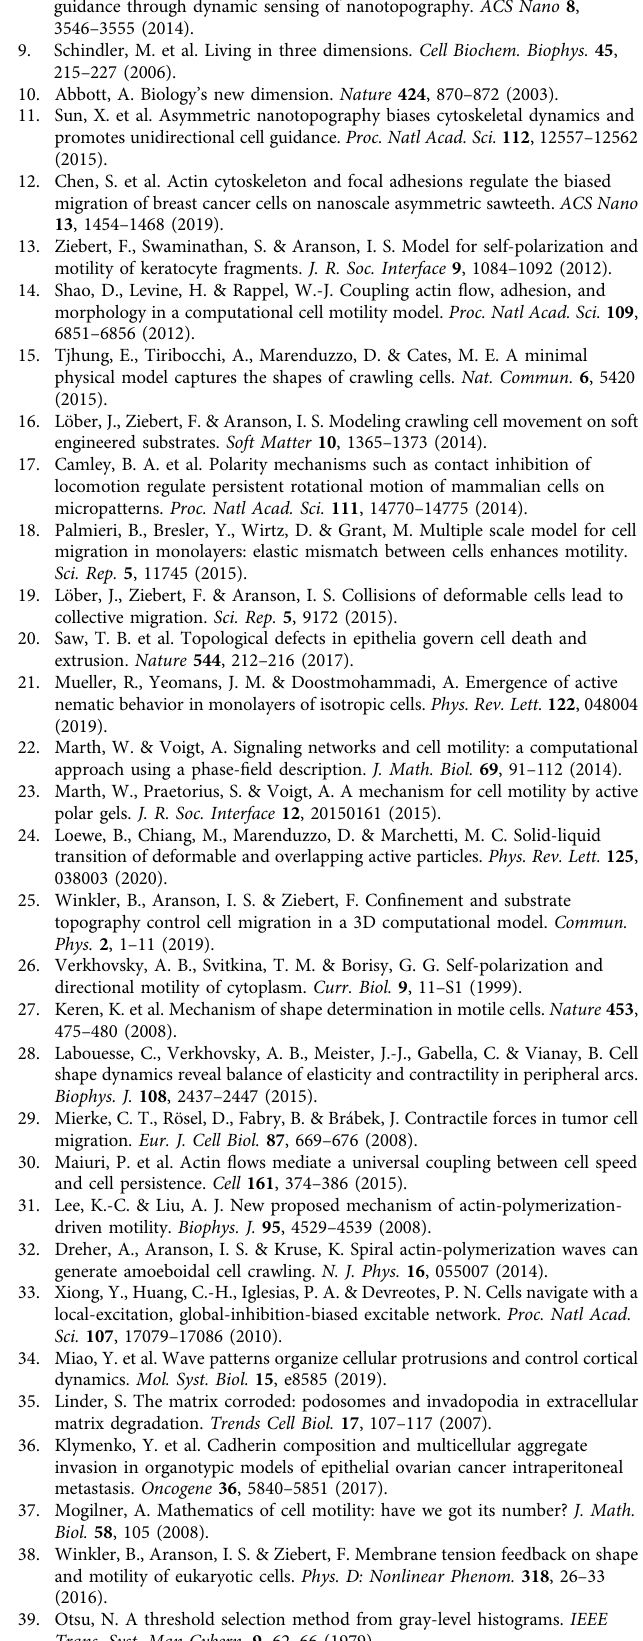
Table 1 Default model